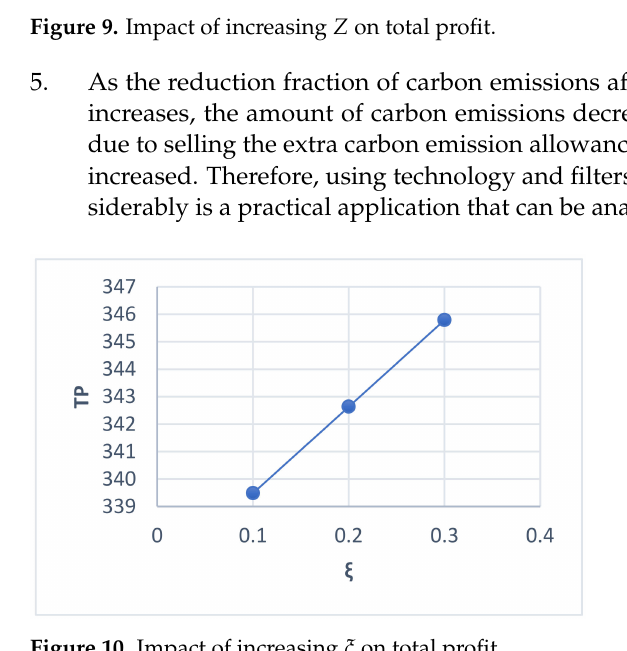
Figure 10. Impact of increasing ξ on total